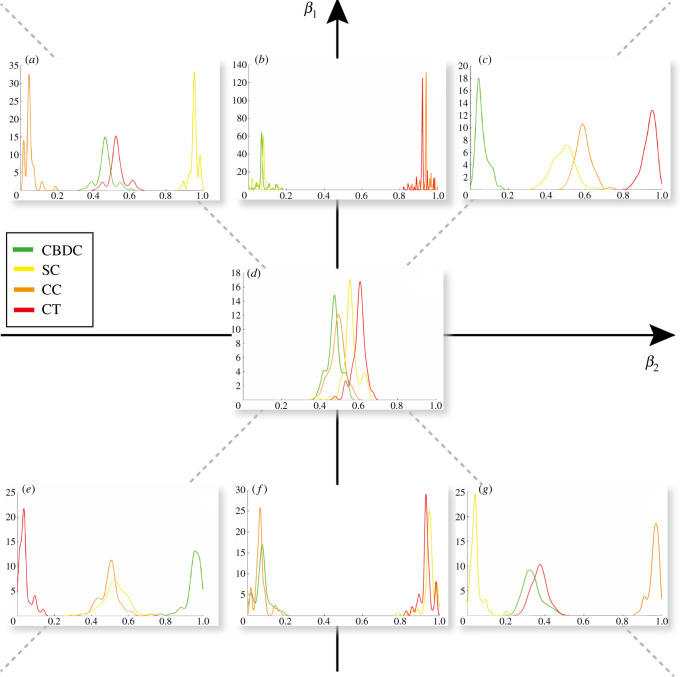
Phase diagram of the system varying the parameters β1, β2 with β0 = 1. By monitoring the distribution of mean probability of not being adopted 1 − a, conditioned on the assets’ class κ, P(1 − a|κ), we can identify different stable configurations for the system, in different regions of the parameter space. We include a few illustrative examples: (a) β1 = −2, β2 = 2, (b) β1 = 2, β2 = 0.01, (c) β1 = β2 = 2, (d) β1 = β2 = 0.01, (e) β1 = β2 = −2, (f) β1 = −2, β2 = 0.01, (g) β1 = 2, β2 = −2. In all simulations, we consider δ = 0.1, ns = 300, N = 300 and β0 = 1.